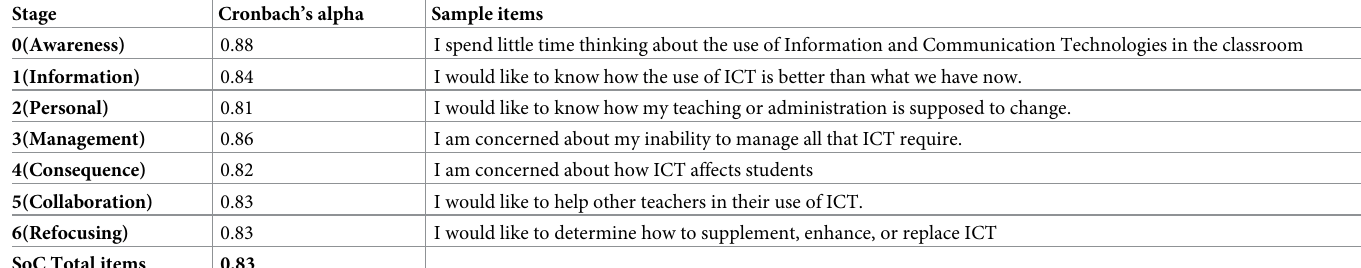
Table 3. Stages of concern reliability